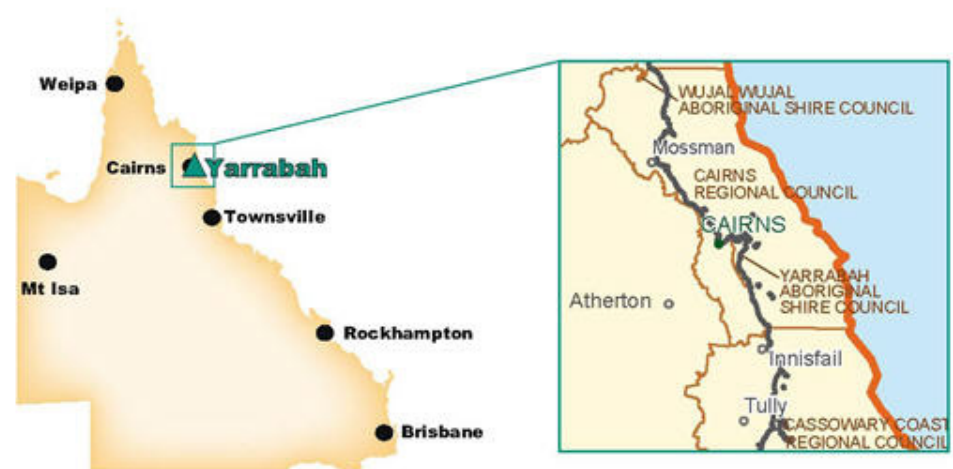
Figure 1. Map of North-East Australia, highlighting the location of Yarrabah.